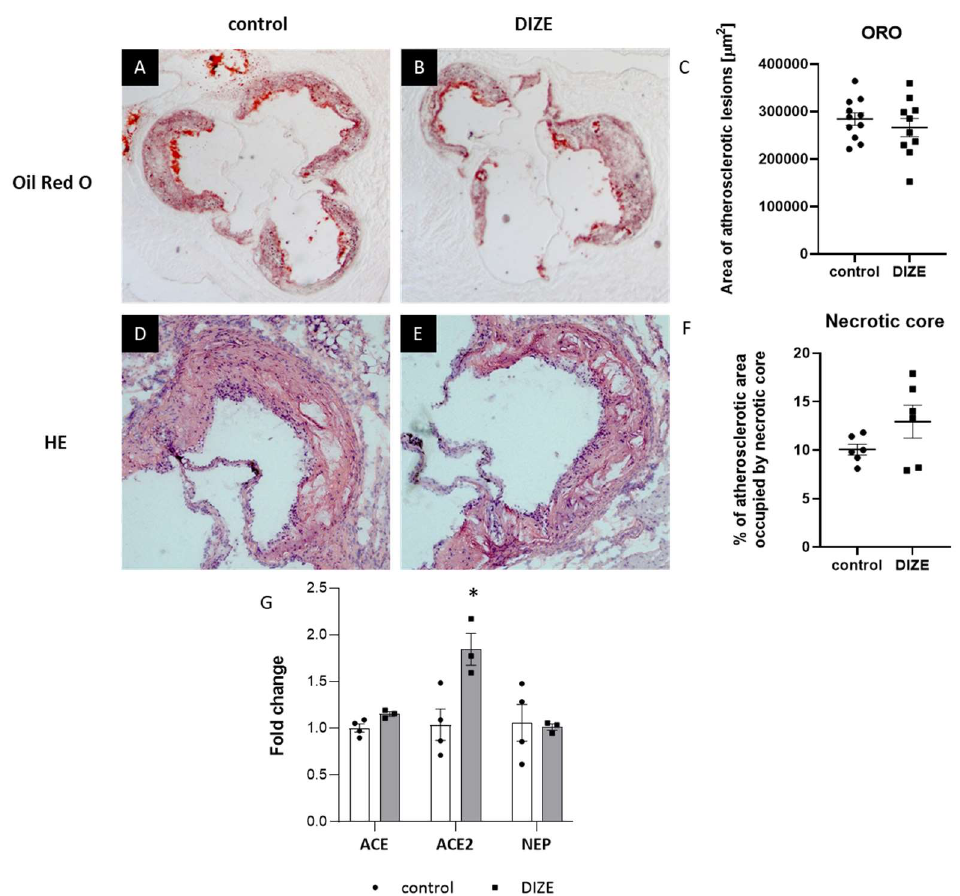
Figure 1. Influence of DIZE on atherosclerosis progression. Representative micrographs showing oil-red O-stained atherosclerotic lesions ( A , B ) and HE-stained necrotic cores ( D , E ) in the aorta of control and DIZE-treated mice as well as their corresponding quantitative analyses ( C , F ). mRNA expression of ACE, ACE2, and NEP in the aorta of control and DIZE-treated mice ( G ). Data are mean ± SEM analyzed using t -test (* p < 0.05 as compared to control; n = 3–11 per group).